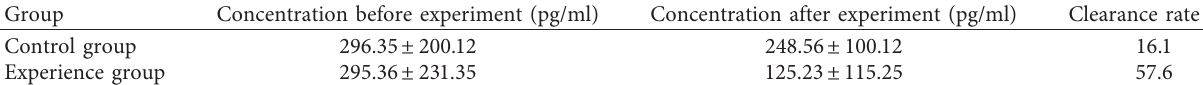
Table 1: Elimination effect of medium molecular toxin (PTH).